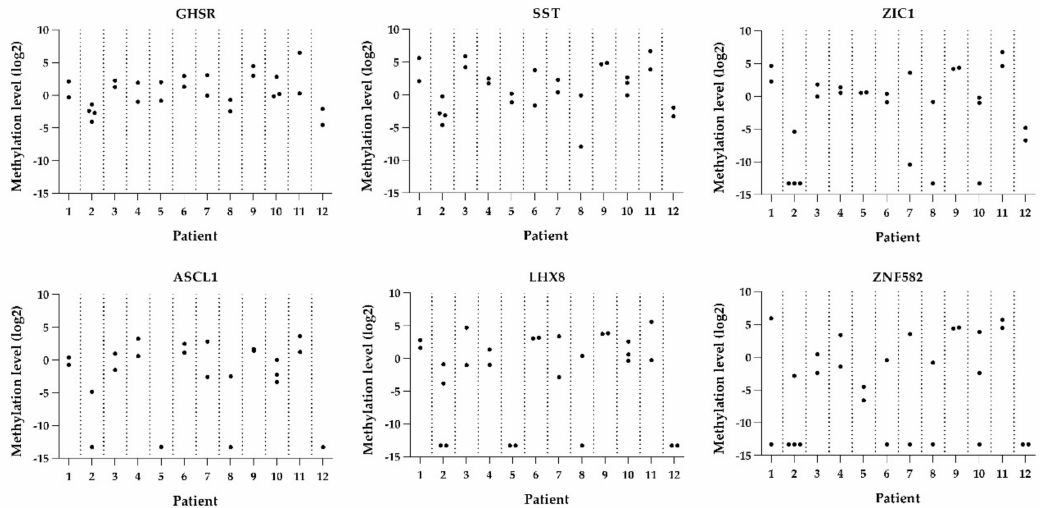
Figure 2. Methylation levels per lesion per patient for all six genes ( GHSR, SST, ZIC1, ASCL1, LHX8, and ZNF582) .